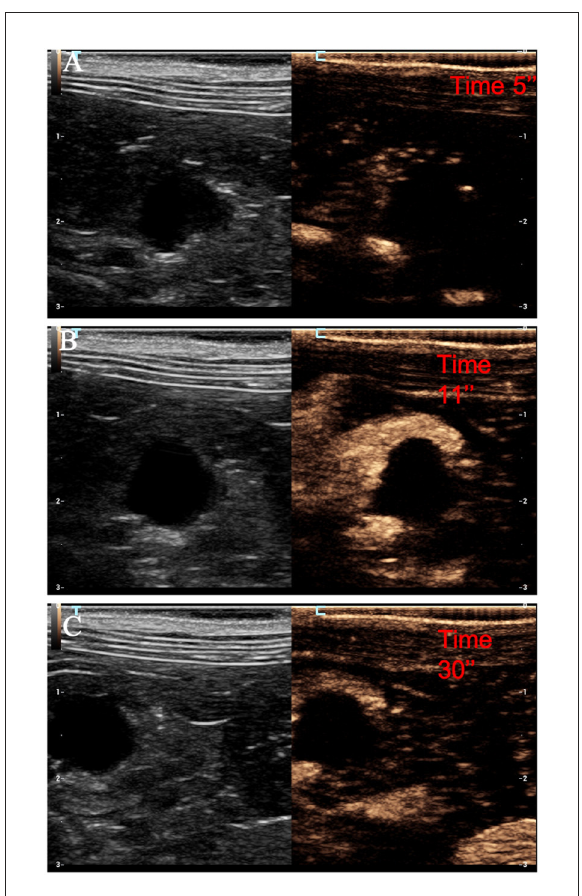
FIGURE6 Example of a cyst showing: no pseudocystic appearance, anechoic lesion, presence of acoustic enhancement, and presence of peripancreatic reactivity at US; non-enhancing at CEUS. (A) Image of the surrounding pancreatic parenchyma obtained at TTE; (B) image of the surrounding pancreatic parenchyma obtained at TTP; (C) image of the surrounding pancreatic parenchyma obtained during